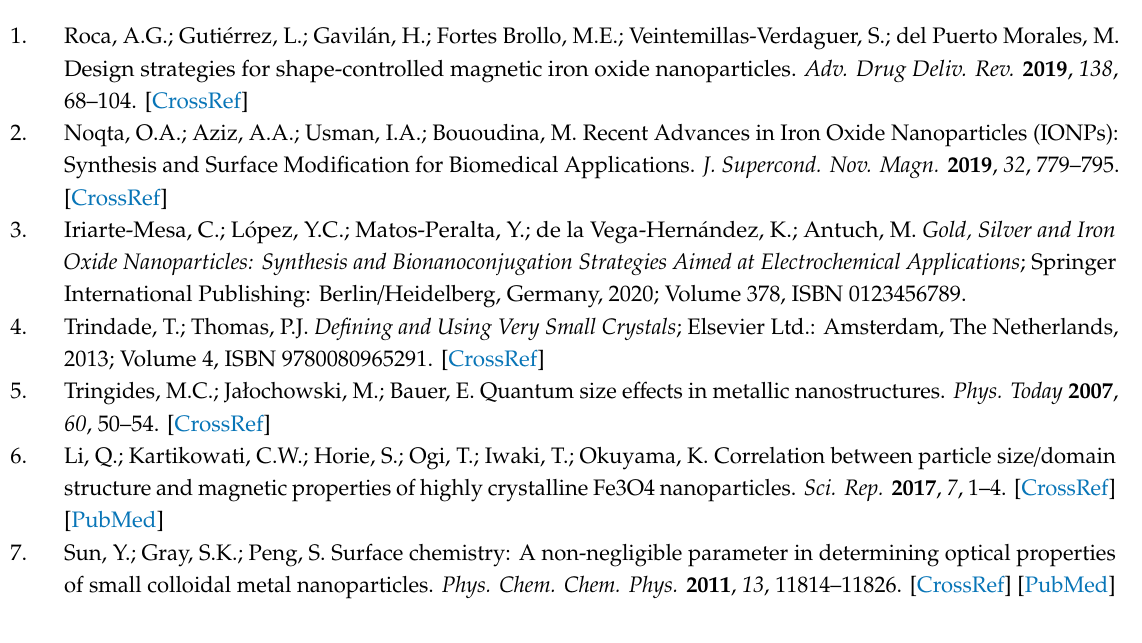
Figure S1: Microwave method for nanoparticle synthesis; Microwaves radiations with frequency ranges from 300 MHz to 300 GHz are used in reaction solution (Most commonly 2.456 GHz is used), Figure S2: Spray pyrolysis method for nanoparticle synthesis; Aerosol droplets undergo evaporation of solvent followed by solute condensation and drying followed by thermolysis of the precipitated particles at high temperature, Figure S3: Co-precipitation method for nanoparticle synthesis; Co-precipitation of various salts like nitrates, sulphates, chlorides, perchlorates etc. is carried out. This co-precipitation is carried out under fine control of pH by using solutions of NaOH, NH4OH to yield corresponding oxide nanoparticles, Figure S4: Microemulsion method for nanoparticle synthesis; When micro emulsion containing reactants are mixed together, due to the reaction micro droplets are formed. Due to the presence of surfactant, fine micro droplets of aqueous get trapped within surfactant molecule assembles. Micro cavities stabilized by surfactant can provide locking up e ff ect that limits particle nucleation, growth, agglomeration results in nanoparticle formation, Figure S5: Polyol method for nanoparticle synthesis; Polyols also control particle growth and prevent aggregation of particles. Precursor is suspended into liquid polyol and system is heated up to boiling point of polyol. Precursor is reduced to nuclei and subsequently nanoparticles synthesized, Figure S6: Sol gel method for nanoparticle synthesis; Mainly three steps: (1) Preparation of sol, (2) Successive gelation, (3) Removal of solvent, Various nanocomposites either crystalline or amorphous can be synthesized with controlled porosity in bulk amounts by using this method, Figure S7: Thermal decomposition method for nanoparticle synthesis; Thermal decomposition of a metallic precursor in presence of organic surfactant is carried out. Synthesis is generally carried out at high temperature. Highly monodispersed particles with a narrow size distribution can be synthesized with this method, Figure S8: IONPs based SERS i.e., Surface Enhanced Raman Spectroscopy (a), IONPs based nucleic acid extraction